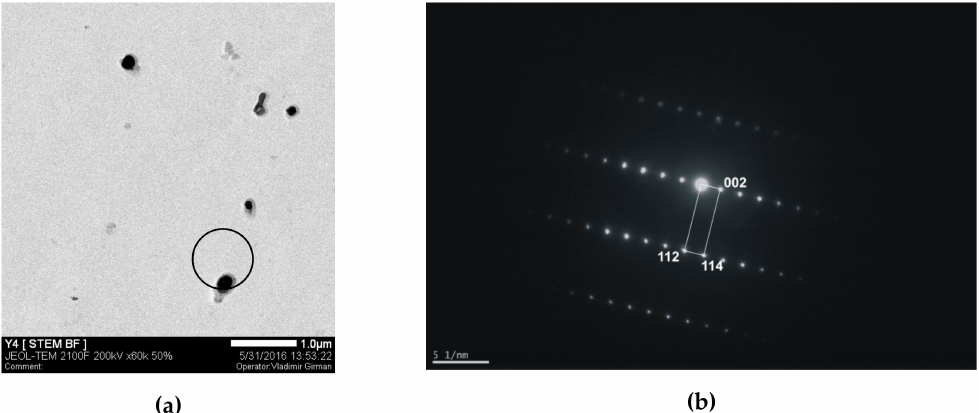
Figure 11. ( a ) TEM, particles in sample Y4, CT1150-2 ◦ , part of complex particle with S, Cu, Ti, O, Nb, Fe; ( b ) Di ff raction pattern, sample Y4, (Ti,Nb) 3 S 4